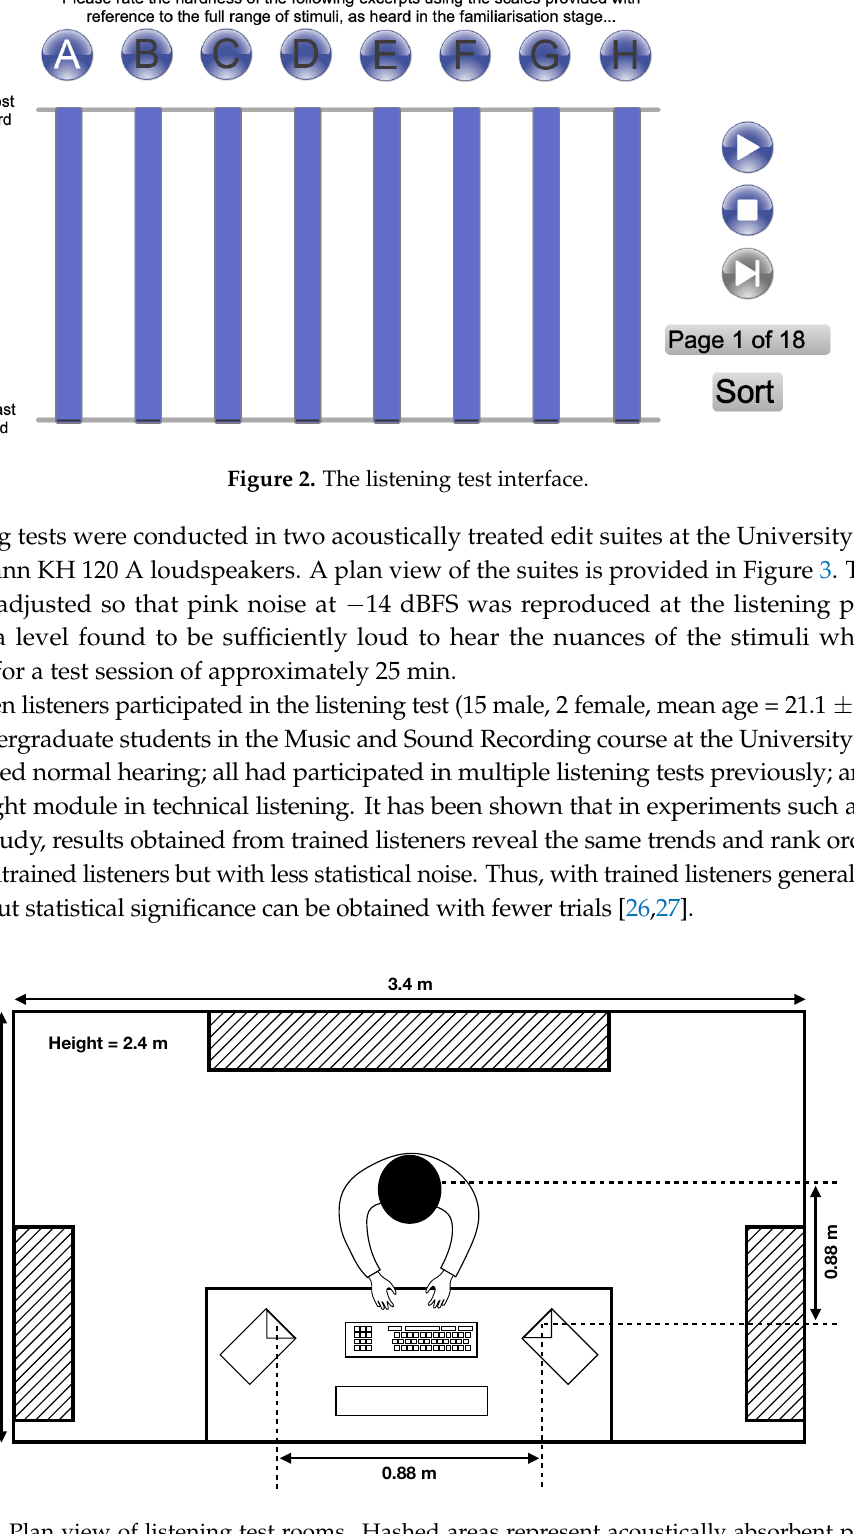
Figure 3. Plan view of listening test rooms. Hashed areas represent acoustically absorbent panels. A fourth panel, 1.25 m by 2.0 m, was attached to the ceiling in the centre of the room. Height refers to the floor-to-ceiling distance, ignoring the fourth acoustic